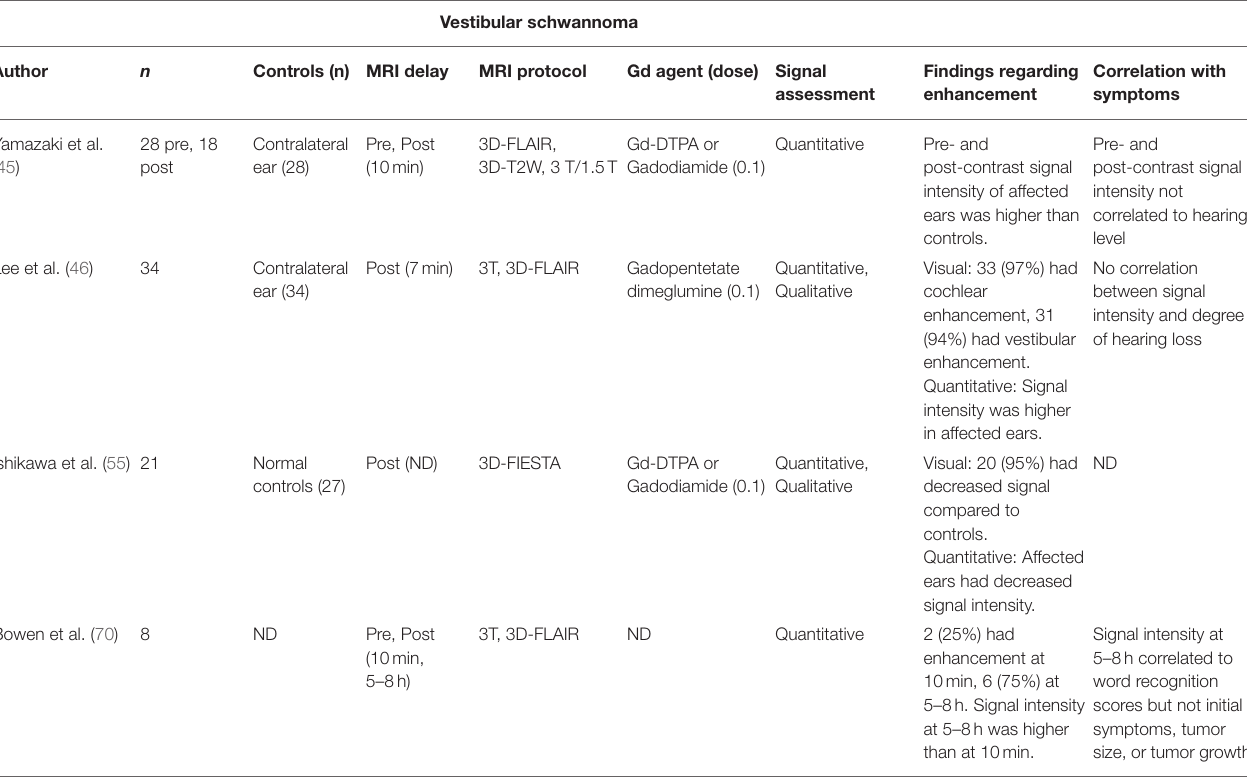
TABLE 5 | Summary of findings in studies of vestibular